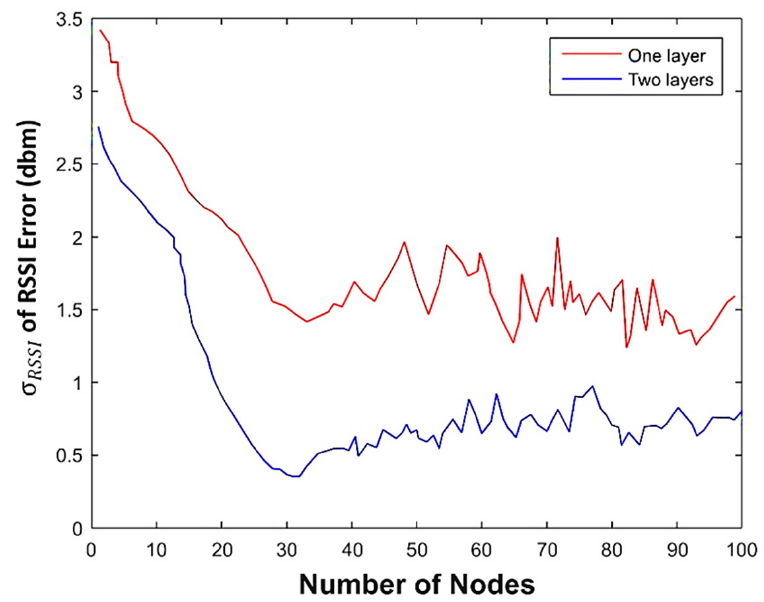
Figure 13. The standard deviation of the output errors of MLP in various layers and neurons.